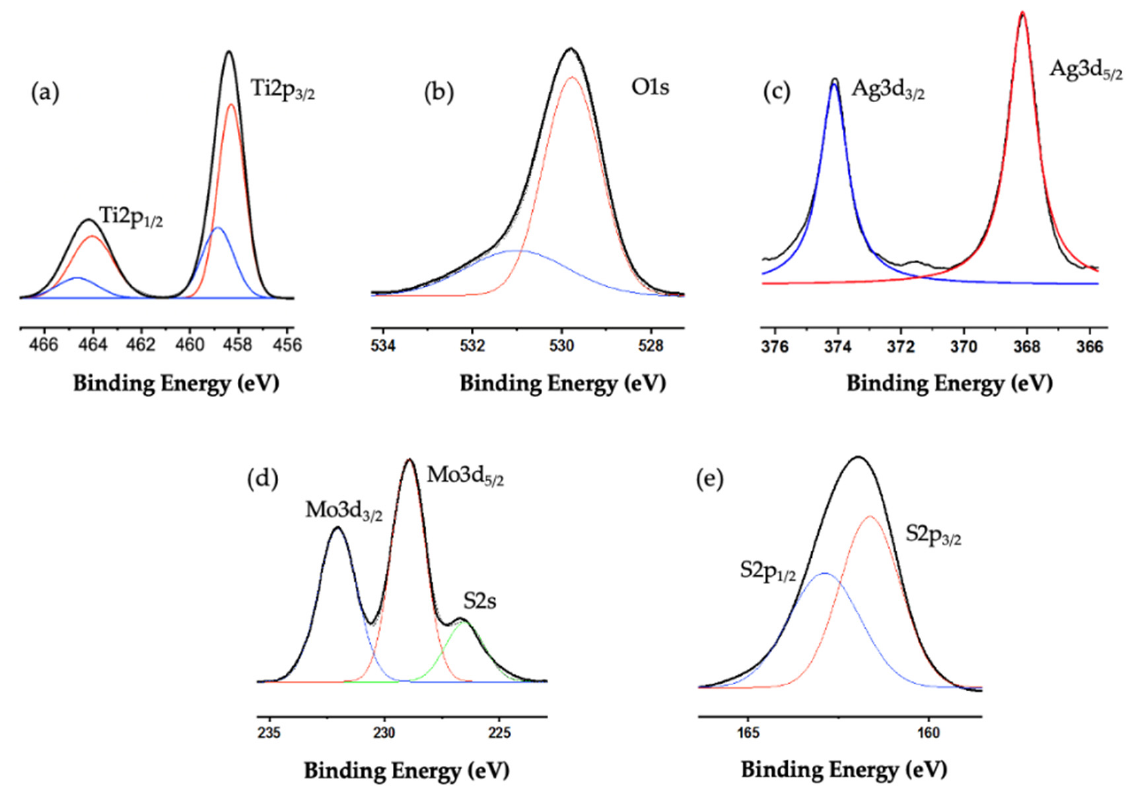
Figure 4. XPS spectra of Ti 2p ( a ), O 1s ( b ), Ag3d ( c ), Mo3d ( d ), and S2p (e) from 5%Ag@TiO 2 NW-20%MoS 2 .